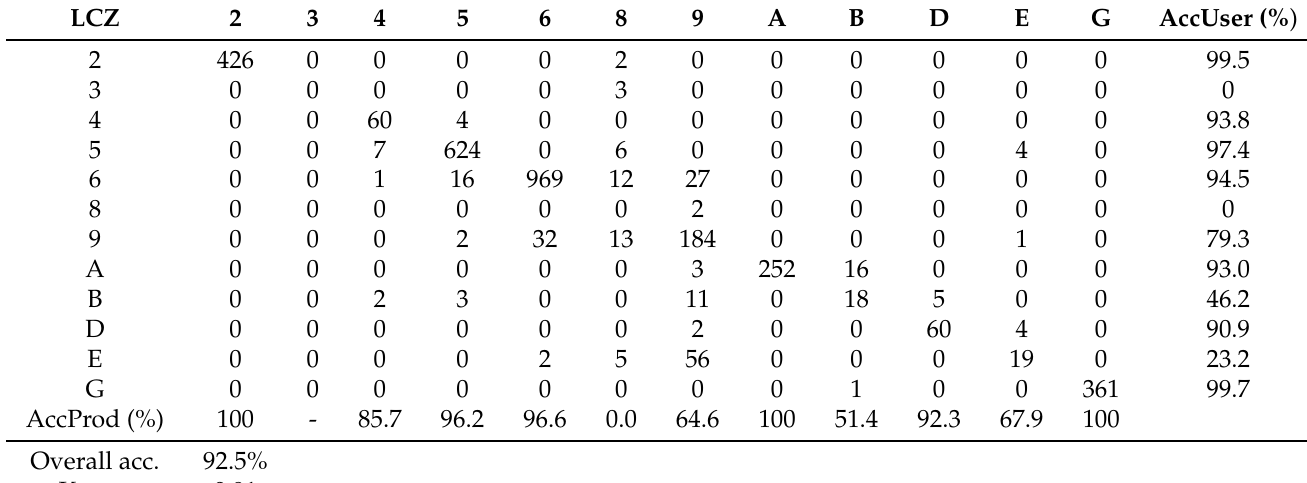
Table 3. Confusion Matrix of GIS-LCZ vs. TA.